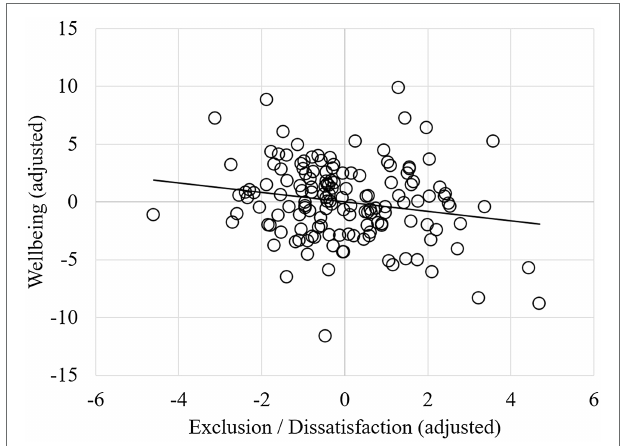
FIGURE 3 | Partial regression plot showing the relationship between wellbeing and exclusion/dissatisfaction (controlling for other variables in the